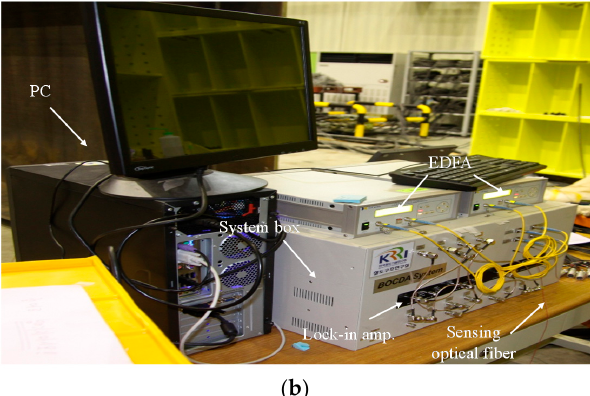
Figure 1. Distributed optical fiber sensor system based on the Brillouin optical correlation domain analysis (BOCDA) technique: ( a ) schematic diagram of the BOCDA system; ( b ) configuration of the optical fiber sensor system.